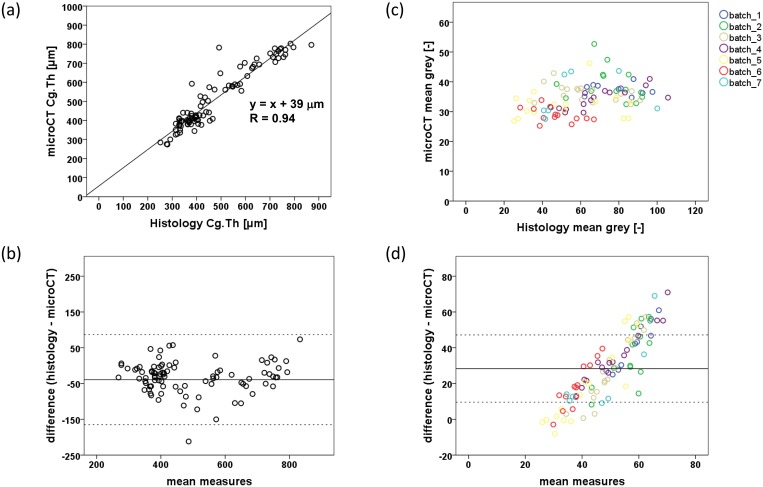
Comparison of microCT and histology.(a) Plot of 2D cartilage thickness measured by microCT against histology, R = 0.94, p < 0.001, and (b) a Bland-Altman plot showing relatively even scatter at both low and high values of mean measures, indicating no obvious trend of increasing scatter with Cg.Th. (c) Plot of mean grey value measured with microCT against histology (grouped by staining batch), and (d) a Bland-Altman plot showing the spread of scatter points with a strong proportional bias with increasing mean measures, independent of histology staining batch.